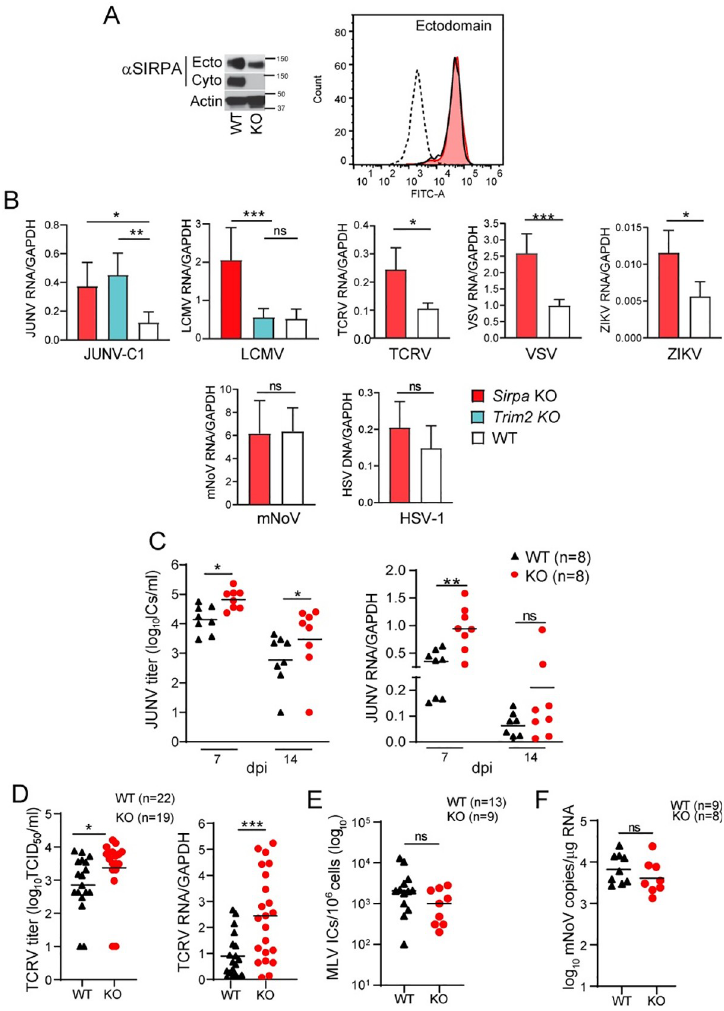
Fig 4. SIRPA KO renders cells and mice more susceptible to virus infection. A) SIRPA expression in BMDMs isolated from WT and SIRPA KO mice was analyzed in total cell extracts by western blot, using antibodies to the ectodomain or cytoplasmic tail and by FACS, using antibody to the ectodomain. The molecular weight (MW) of mouse SIRPA is 110kD. B) BMDMs isolated from mice of the indicated genotype were infected with the specified viruses and RNA was isolated at 14 hpi (VSV, mNoV), 24 hpi (JUNV-C1, TCRV, LCMV) or 48 hpi (ZIKV). HSV-1 DNA was isolated at 24 hpi. Viral nucleic acids were examined by qPCR for infection levels. Shown is the average ± SD of 4–6 independent experiments. One-way ANOVA was used to determine significance. � , P � 0.02; �� , P � 0.002; ��� , P � 0.0005. C) Adult mice of the indicated genotype were infected with JUNV-C1 by IP injection, and at 7 or 14 dpi, virus and RNA was isolated from spleens and analyzed for titers and by qPCR. Each point represents an individual mouse. Shown is the average ± SD. Student’s T test with Welch’s correction was used to determine significance. � , P � 0.01; �� , P � 0.004. D) Newborn WT and SIRPA KO mice were infected with TCRV by IP injection. Viral titers and RNA levels in spleen were analyzed at 7 dpi. Student’s T test with Welch’s correction was used to determine significance. � , P � 0.01; ��� , P � 0.001. E) Newborn mice were infected with 2000 ICs of MLV and virus titers in spleen were measured at 16 dpi. F) WT and SIRPA KO mice were orally infected with mNoV strain CW3 and 3 dpi viral RNA levels in spleens were examined. Unpaired t test with Welch’s correction was used to determine significance.